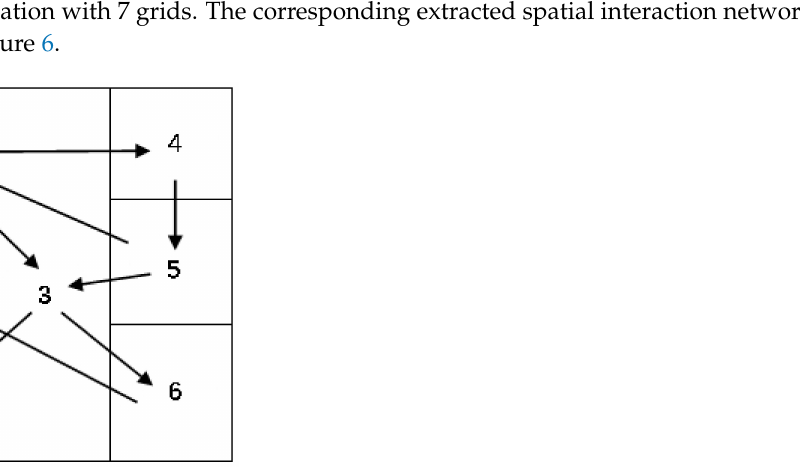
Figure 5. An example of 11 spatial interaction records in a non-overlapping spatial tessellation with 7 grids.